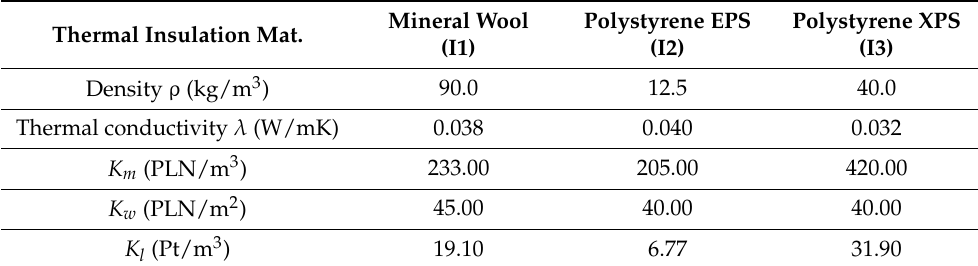
Table 5. Thermal insulation